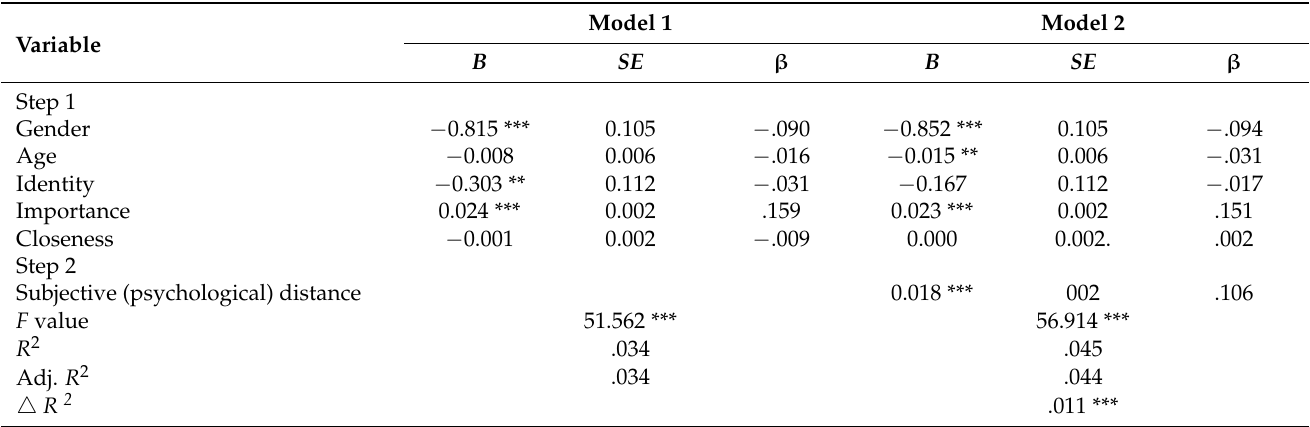
Table 4. Hierarchical OLS regression of demographic variables and subjective (psychologi- cal) distance on the risk perception of COVID-19 in Wuhan ( N = 7284, adult data with no missing values).